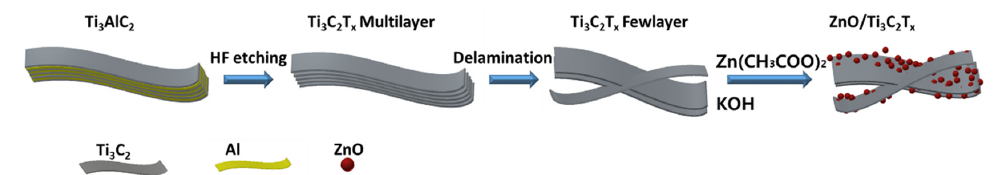
Figure 1. Schematic synthesis procedure of ZnO/Ti 3 C 2 T x heterostructure.